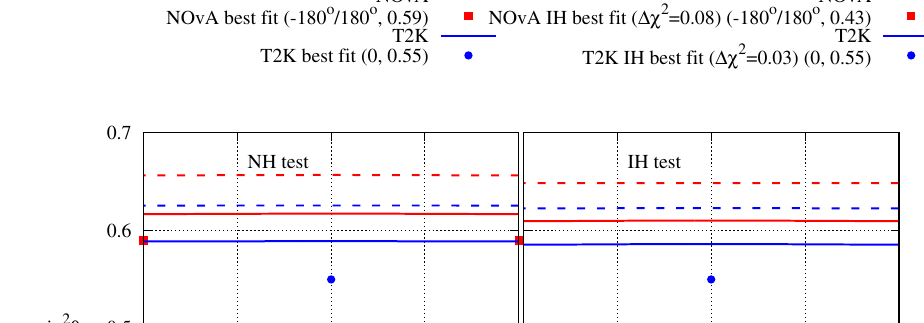
Fig. 2 Allowed region in the sin 2 θ 23 − δ CP plane after analysing NO ν A and T2K ¯ ν μ disappearance data. The left (right) panel represents test hierarchy NH (IH). The red (blue) lines indicate the results for NO ν A (T2K). The solid (dashed) lines indicate the 1 σ (3 σ ) allowed regions. The minimum χ 2 for NO ν A (T2K) with 19 (35) bins is 24.72 (34.64) and it occurs at IH.